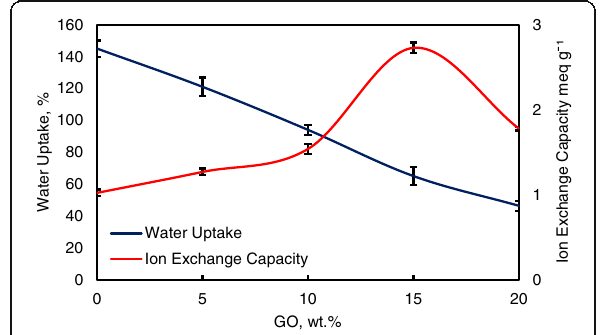
Fig. 9 Ionic conductivity analysis of QPVA membrane and QPVA/GO composite membrane at 30